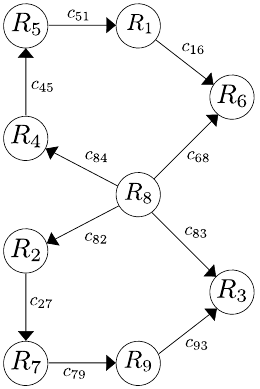
Figure 3. Third desired formation.